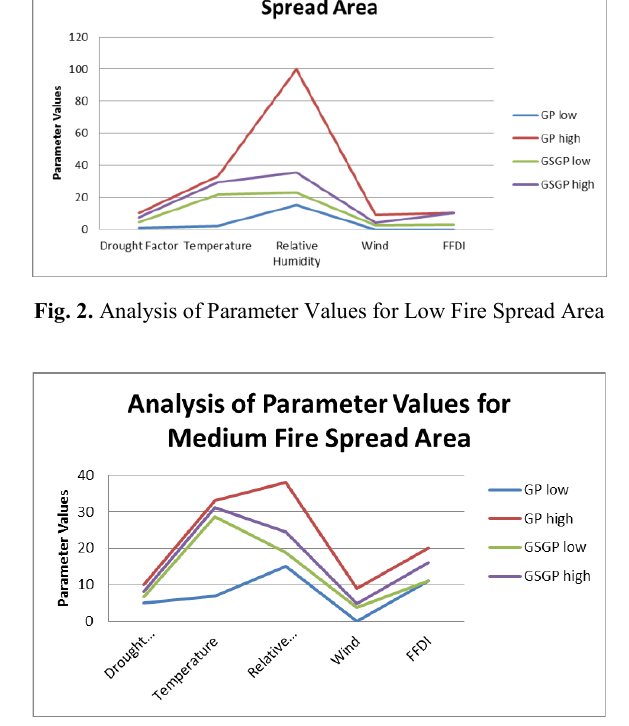
Fig. 3. Analysis of Parameter Values for Medium Fire Spread